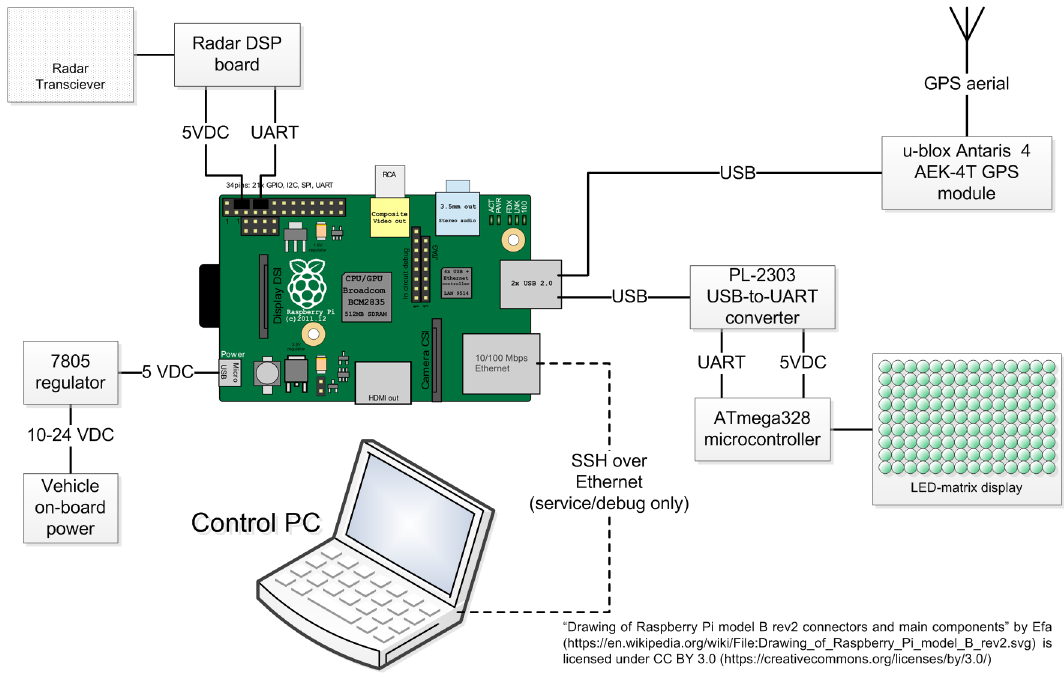
Figure 4. Connection diagram of the prototype device.